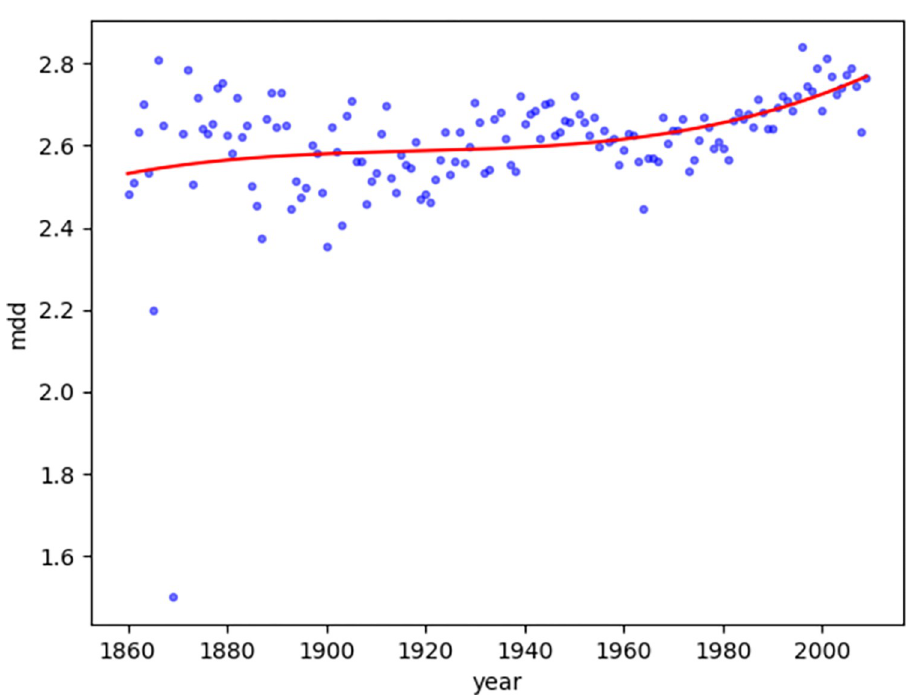
Fig 6. Diachronic non-linear distribution of MDD for news texts.